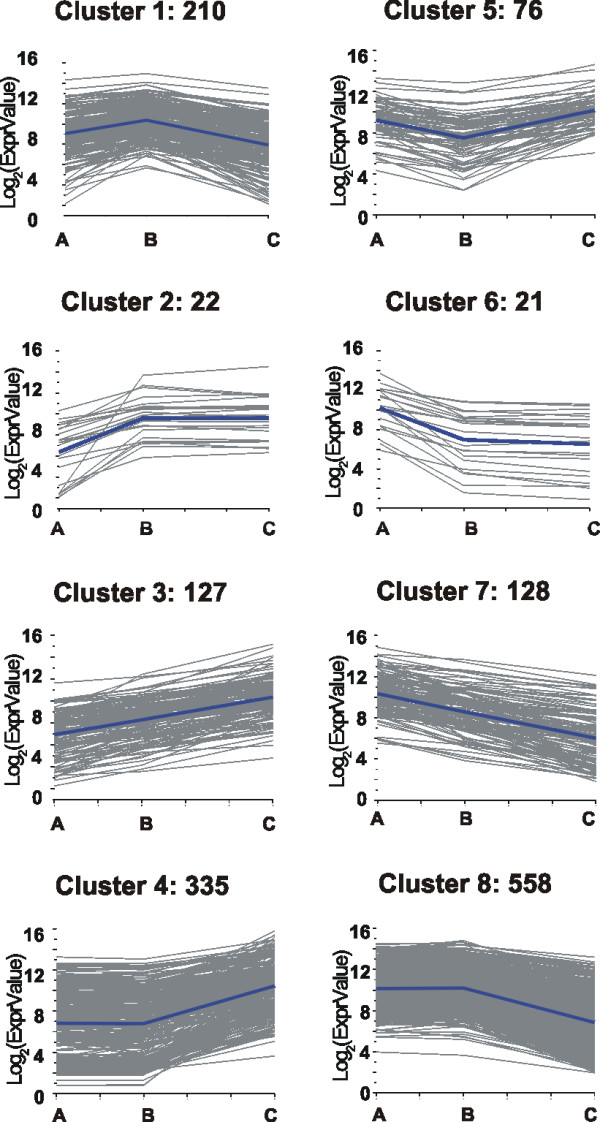
Cluster analysis of the expression profiles of the modulated core set. The expression profiles of the 1477 modulated genes during P. Noir berry ripening were clusterised in eight clusters which represent the minimum number of profiles considering three time points. Clusters were obtained by the k-means method using Pearson's correlation distance. The representative profile and the number of genes in each cluster are indicated.